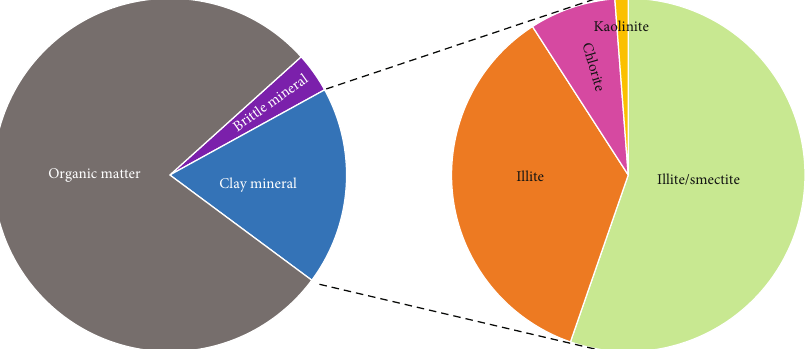
Figure 9: Theoretical calculation of adsorbed gas proportion. The adsorption capacity of organic matter was the highest, followed by clay minerals, and the adsorption capacity of brittle minerals was the